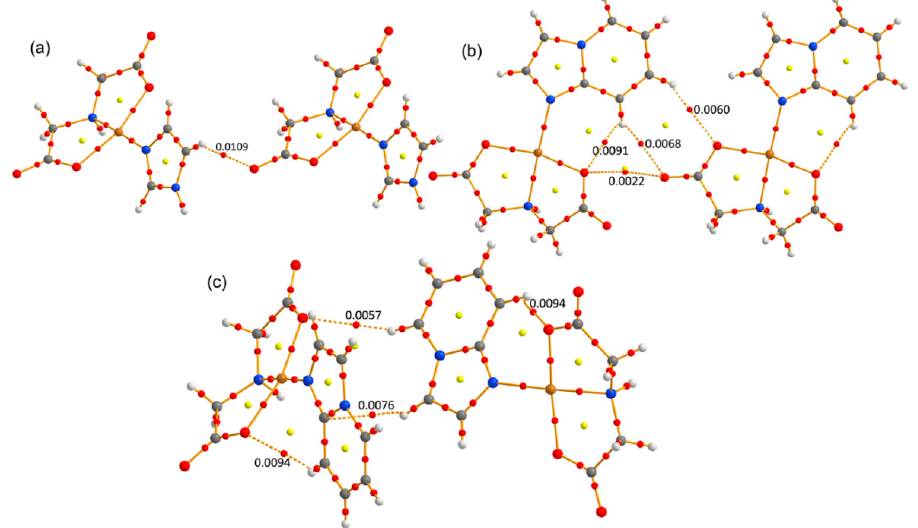
Figure 9. AIM analysis of different models ( a – c ). Red and yellow spheres represent bond and ring critical points, respectively. The bond paths connecting bond critical points are shown as dashed lines. The values of ρ (r) at the bond critical points are given in atomic units (a.u.).